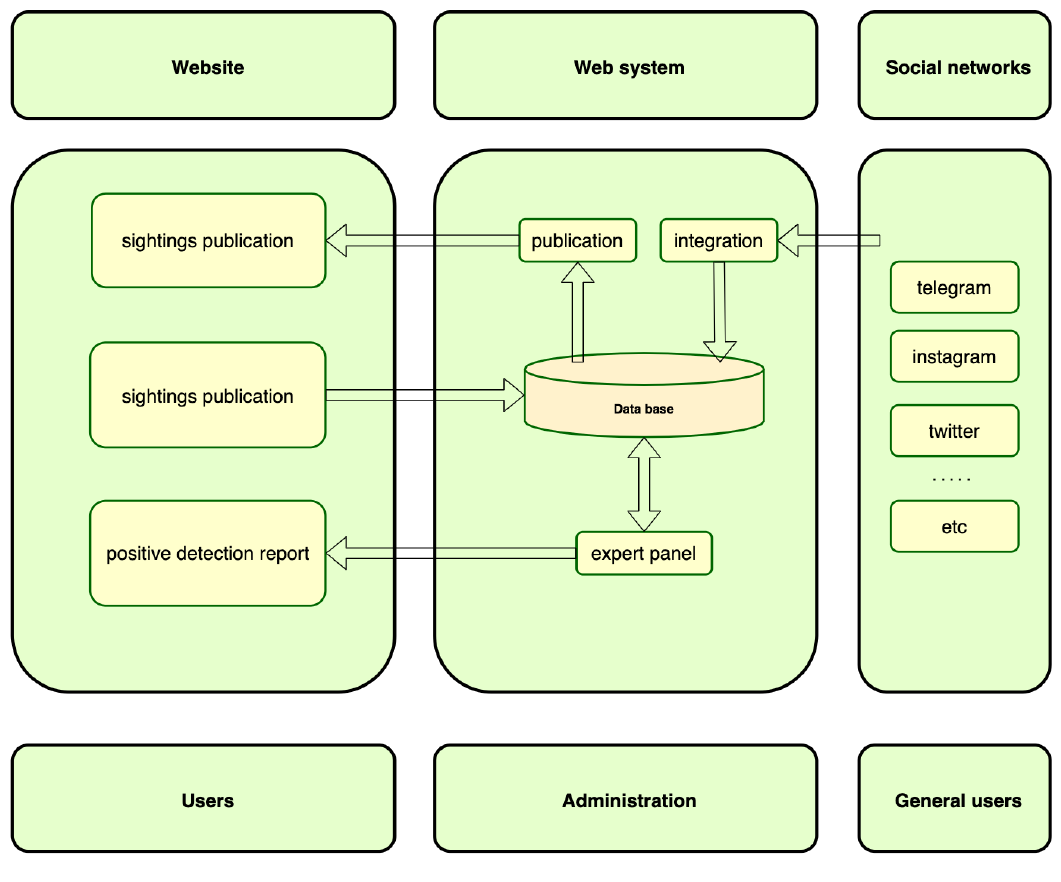
Figure 5: System